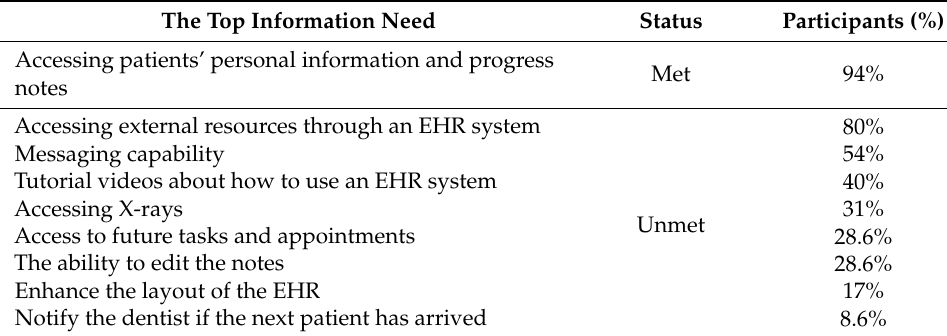
Table 2. Specific information